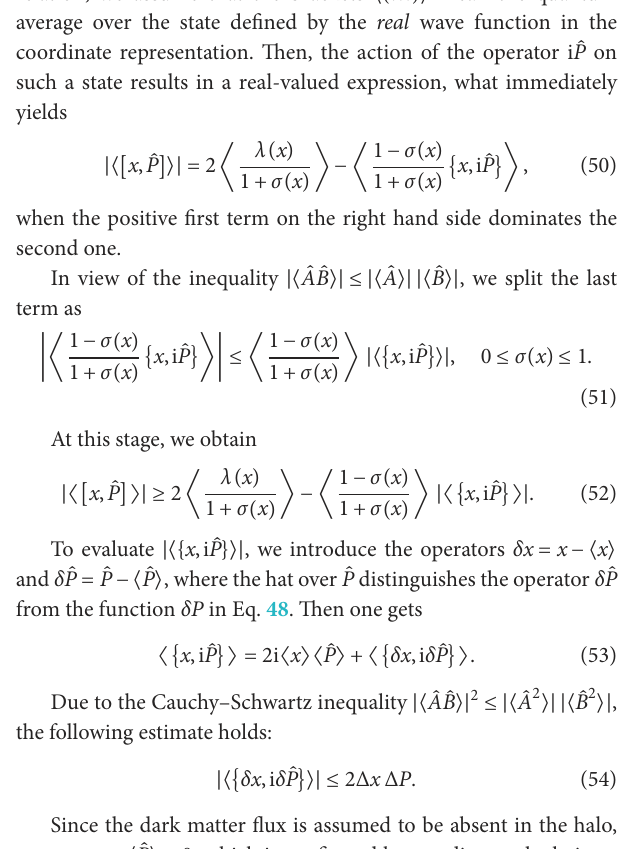
It is immediately seen